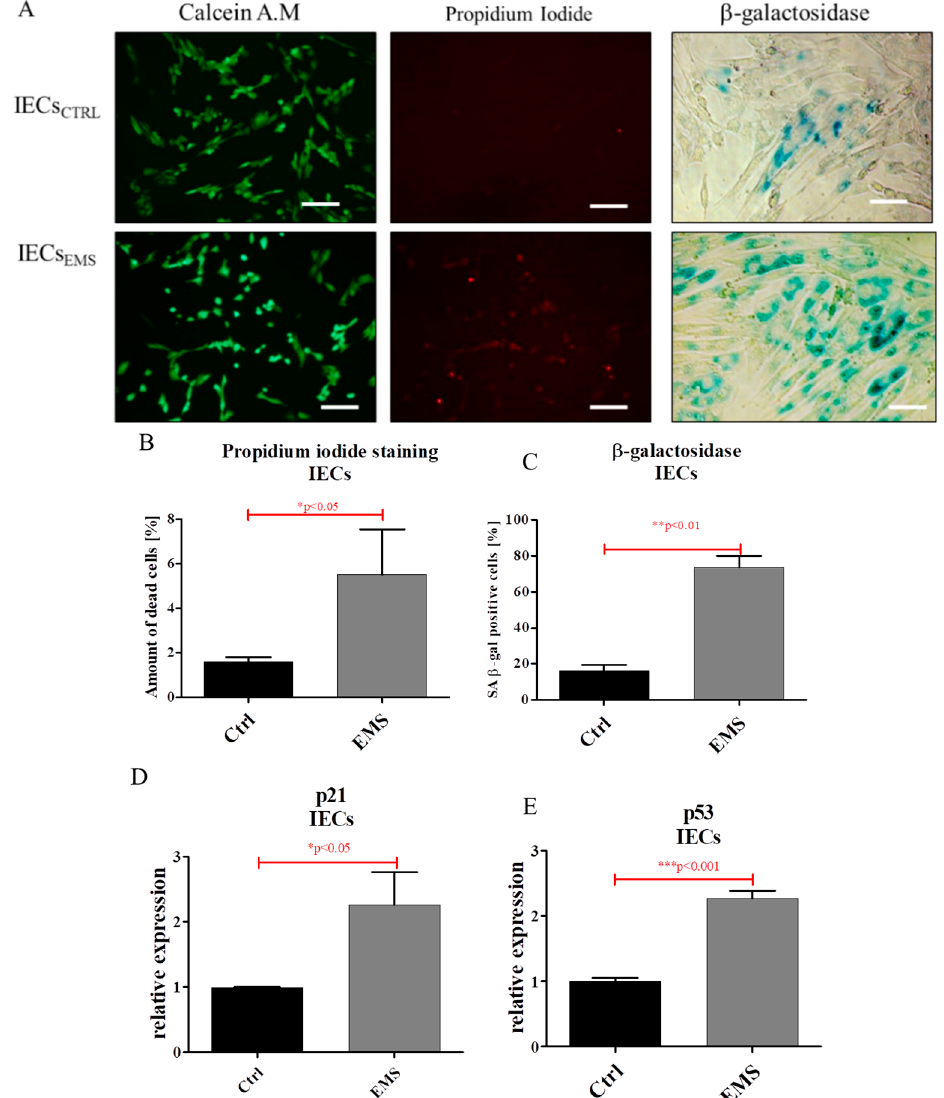
Figure 4. Evaluation of apoptosis and senescence in IECs CTRL and IECs EMS . Fluorescence staining of live/dead cells and accumulation of β -galactosidase ( A ). Quantification of images acquired with calcein/propdium iodide ( B ) and senescence stainings ( C ). Using RT-PCR, expression of following transcripts was investigated for p21 ( D ) and p53 ( E ). Scale bars: 400 µ m. Results expressed as mean ± S.D. * p < 0.05, ** p < 0.01, *** p < 0.001.